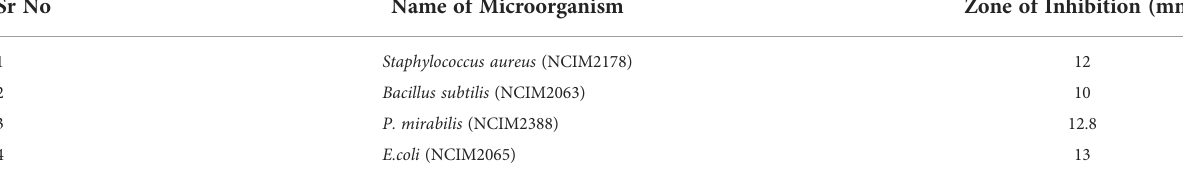
TABLE 5 Antibacterial activity of Sargassum extract (Concentration of the sample - 1mg/ml). Sr